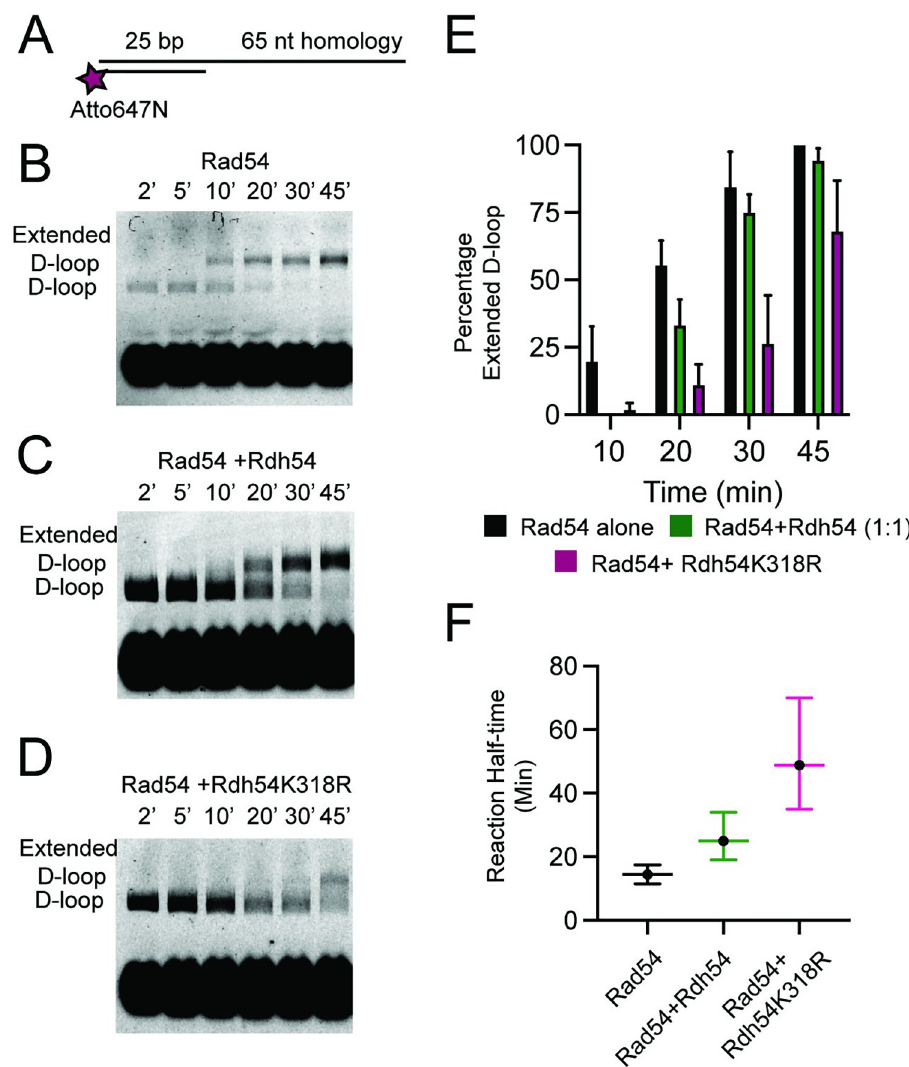
Fig 5. Rdh54 kinetically effects D-loop maturation on longer DNA templates. (A). Schematic diagram illustrating the longer fluorescently recipient DNA used in this experiments. The recipient DNA used in this experiment was 65 nt of homologous ssDNA and 25 bp of non-homologous dsDNA (B). Representative agarose gel representing a D-loop extension assay with Rad54 (30 nM) at 2, 5, 10, 20, 30, and 45 minutes. (C). Representative agarose gel representing D- loop extension assay with Rad54 (30 nM) + Rdh54 (30 nM) at 2, 5, 10, 20, 30, and 45 minutes. (D). Representative agarose gel representing D-loop extension assay with Rad54 (30 nM) + Rdh54K318R (30 nM) at 2, 5, 10, 20, 30, and 45 minutes. (E). Bar graph representing quantification of the fraction of D-loops that are extended at 10, 20, 30, and 45 min. The error bars represent the mean and standard deviation of 4–10 independent experiments. (F). A plot illustrating the reaction half-time generated from a single-phase association fit of the percentage D-loop extension. The crossbars represent the mean, and the error bars represent the upper and lower limit of the half-time based on the fit of the